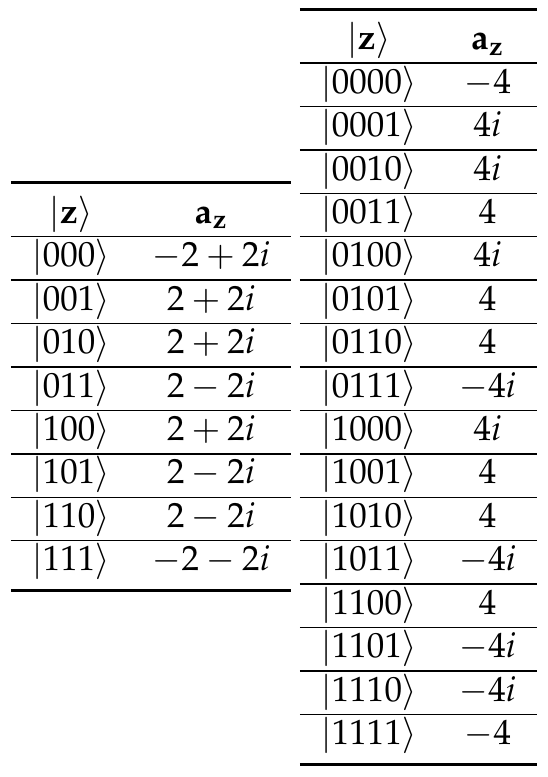
Table 1. (Left) The amplitudes of a z for n = 3. (Right) The amplitudes of a z for n = 4. In order to get Figure 2. ( Left ) The amplitudes of a z for n = 3. ( Right ) The amplitudes of a z for n = 4. In order to the final amplitudes one should multiply them by a suitable normalization factor. get the final amplitudes one should multiply them by a suitable normalization